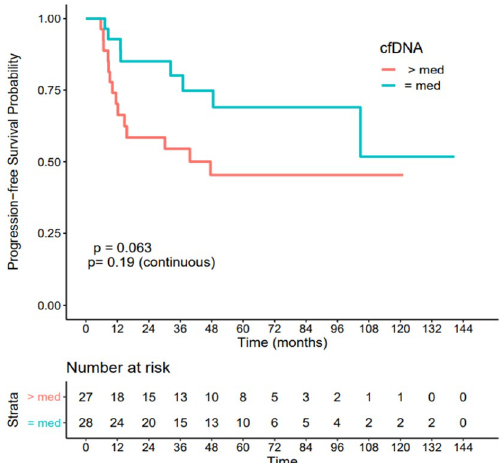
Figure 4. Association between cell-free DNA level at diagnosis and disease-free survival. Patients with cfDNA below the median had a non-significant better DFS outcome (HR = 0.45 CI[0.19–1.07], p = 0.063).